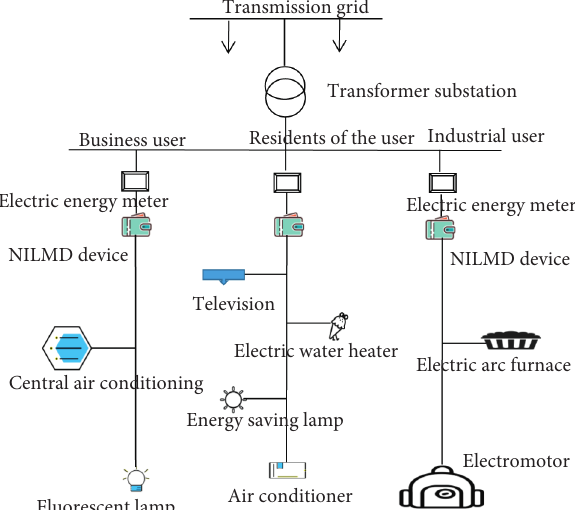
Figure 1: Schematic diagram of noninvasive power load moni- toring and decomposition